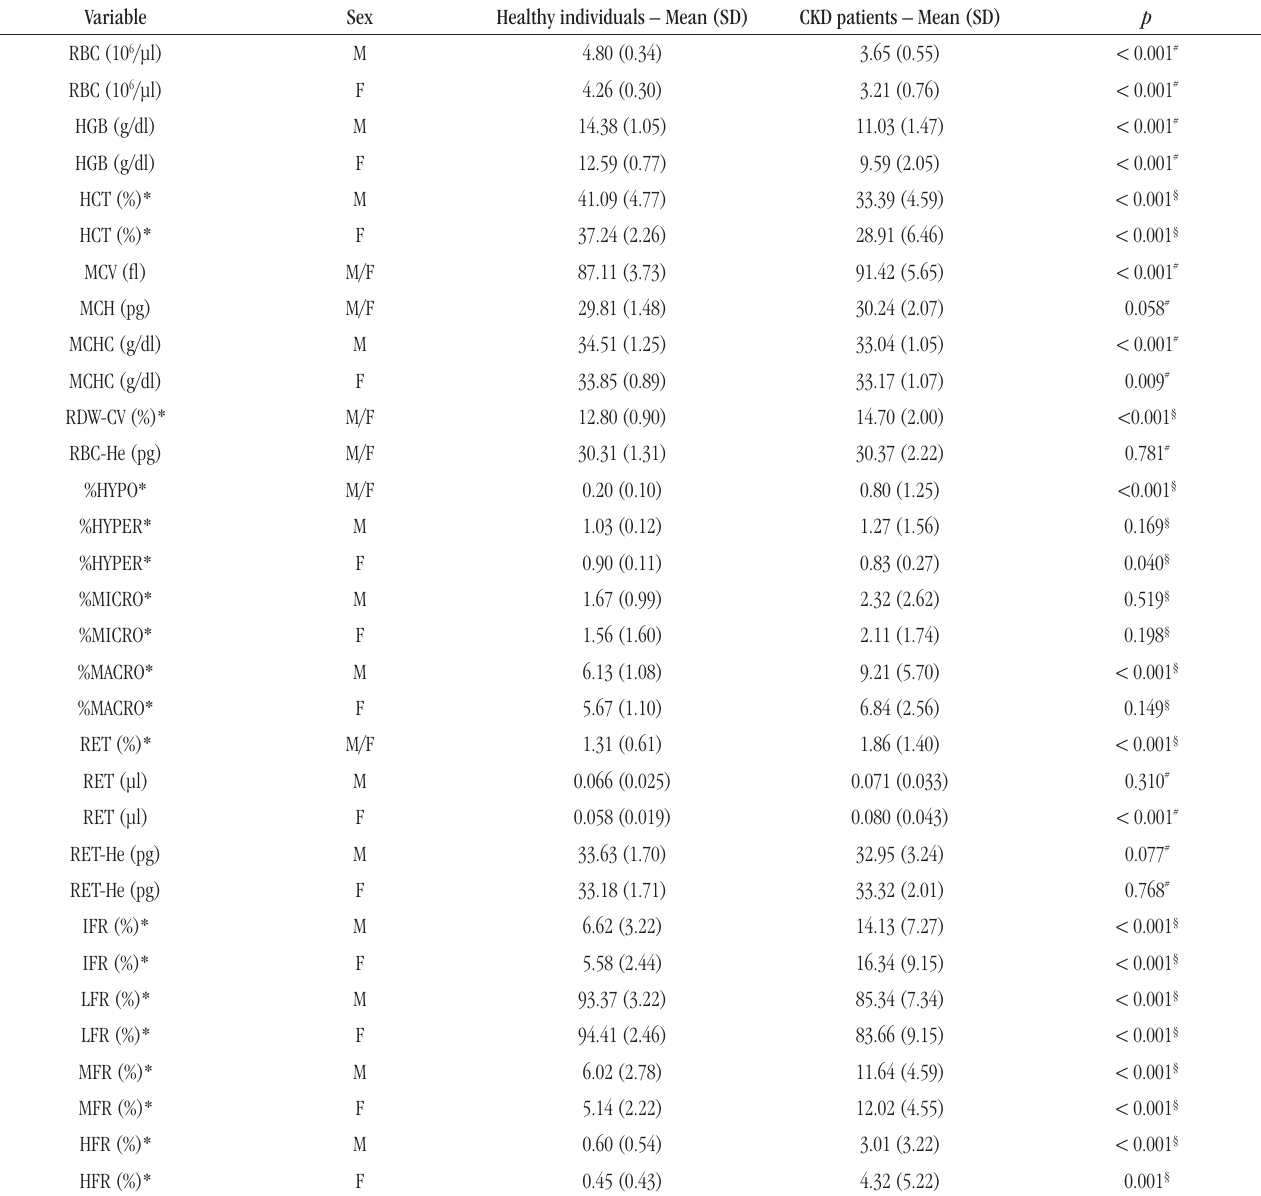
taBLE 2 − Comparison between traditional and extended erythrocyte parameters and reticulocyte indices of healthy individuals and CKD patients Variable Sex Healthy individuals – Mean